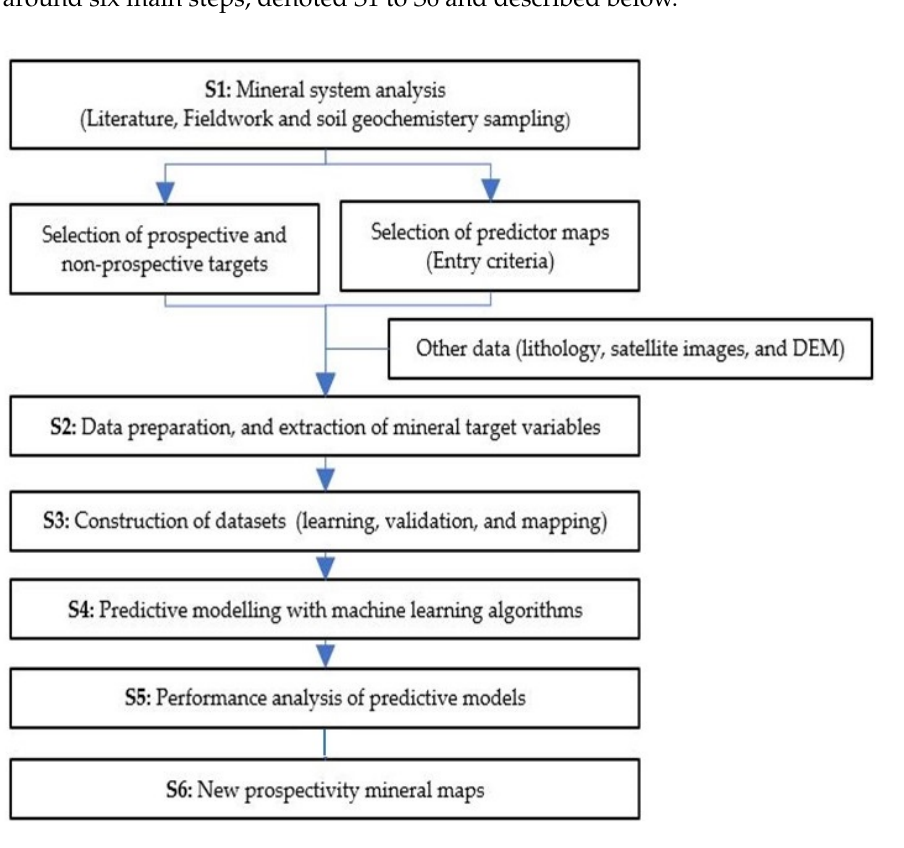
Figure 3. Flowchart summarizing the six research steps.